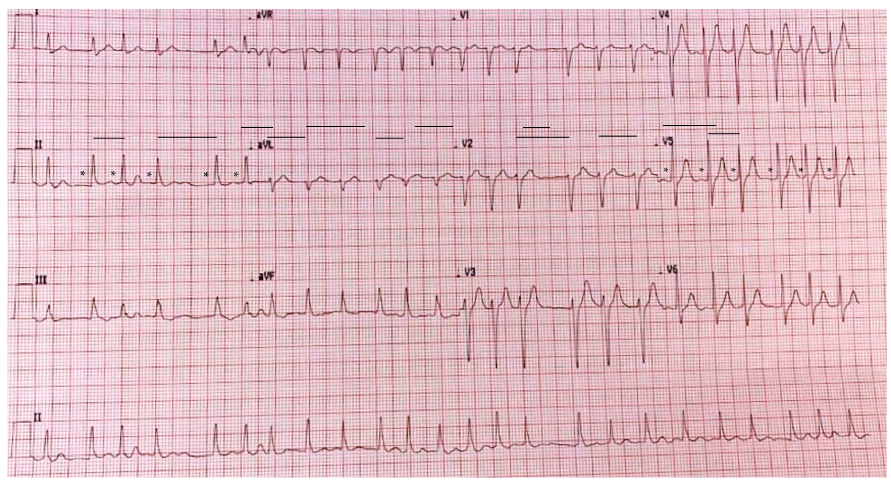
Figure 2. Standard 12-lead ECG showing narrow-complex tachycardia with rapid irregular ventricular rate (black lines) and absence of P waves (black asterisks). On physical examination, his blood pressure was 140/80 mmHg, and peripheral oxygen saturation was 99% on room air. Calculated CHA 2 DS 2 -VASc and HAS-BLED scores were 0 and European Heart Rhythm Association (EHRA) scale was graded 2a. Complete blood count, electrolytes, coagulation panel, inflammatory markers, liver and renal function, lipid profile, glycaemia, cardiac enzymes, and thyroid hormones were within the respective reference ranges (Table 1). Table 1. Laboratory values of the patient on admission.